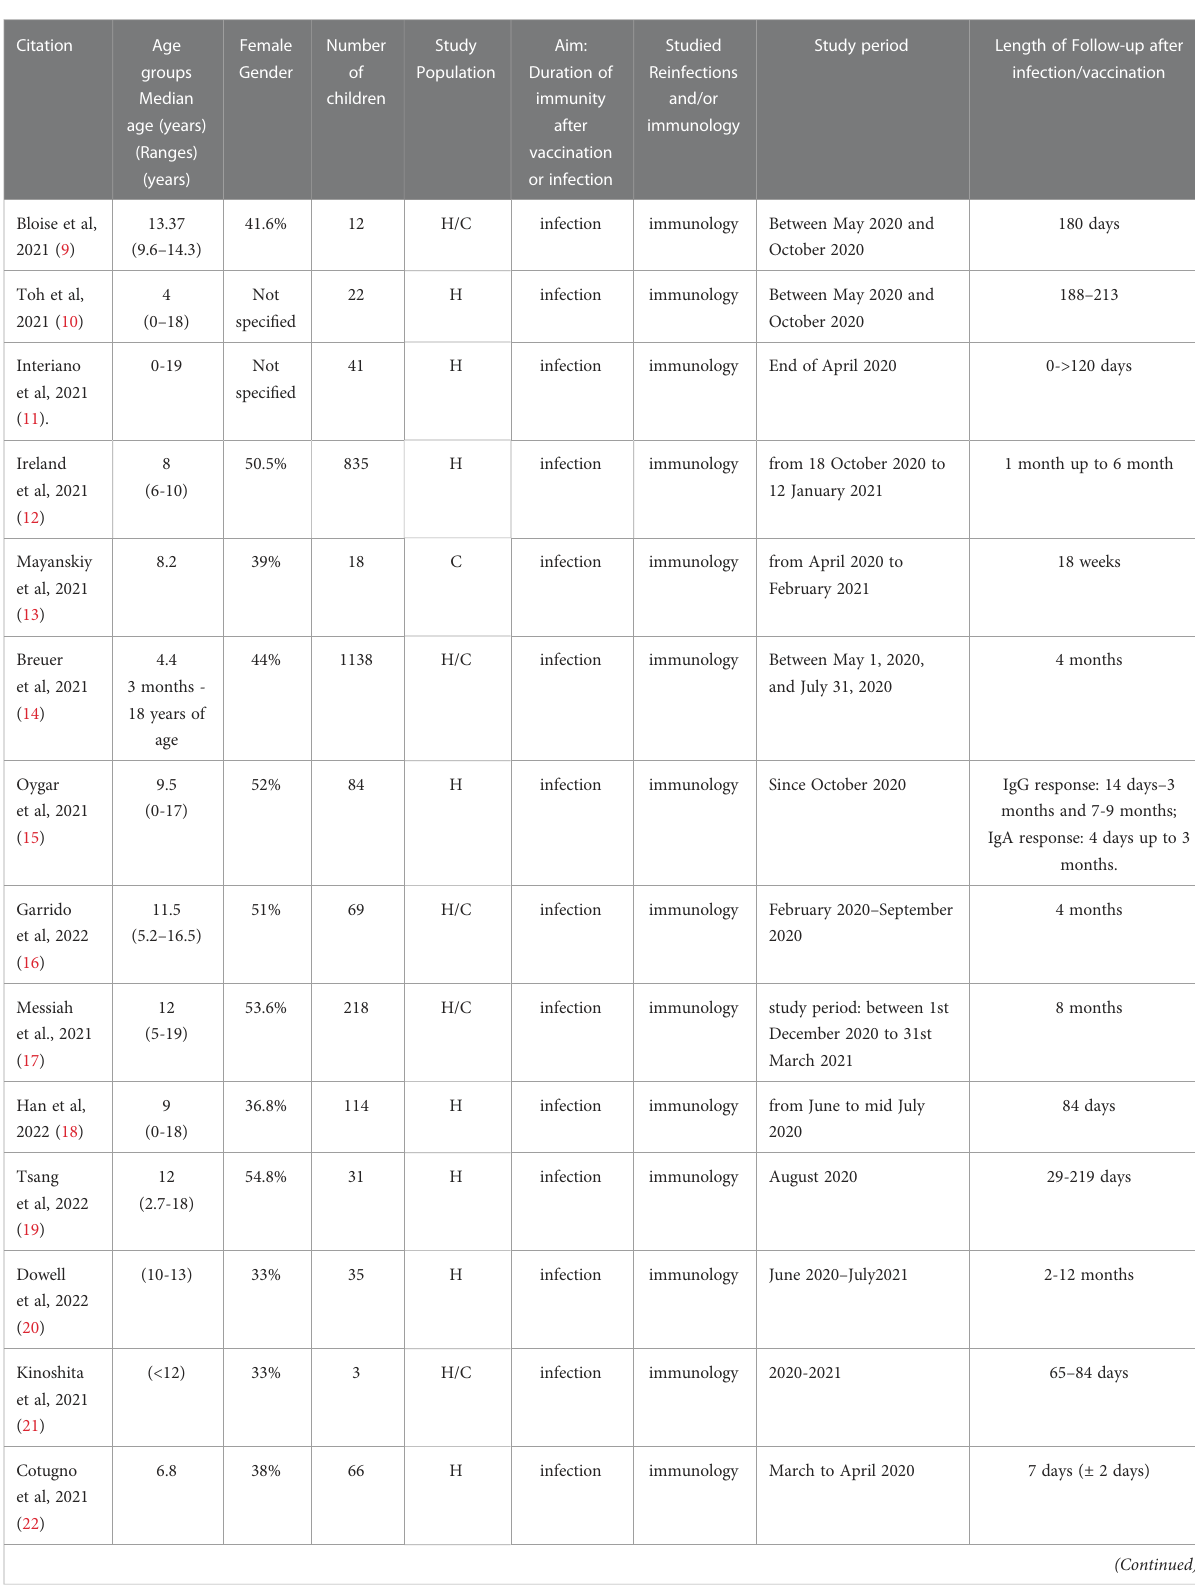
TABLE 1 Main characteristics of the included